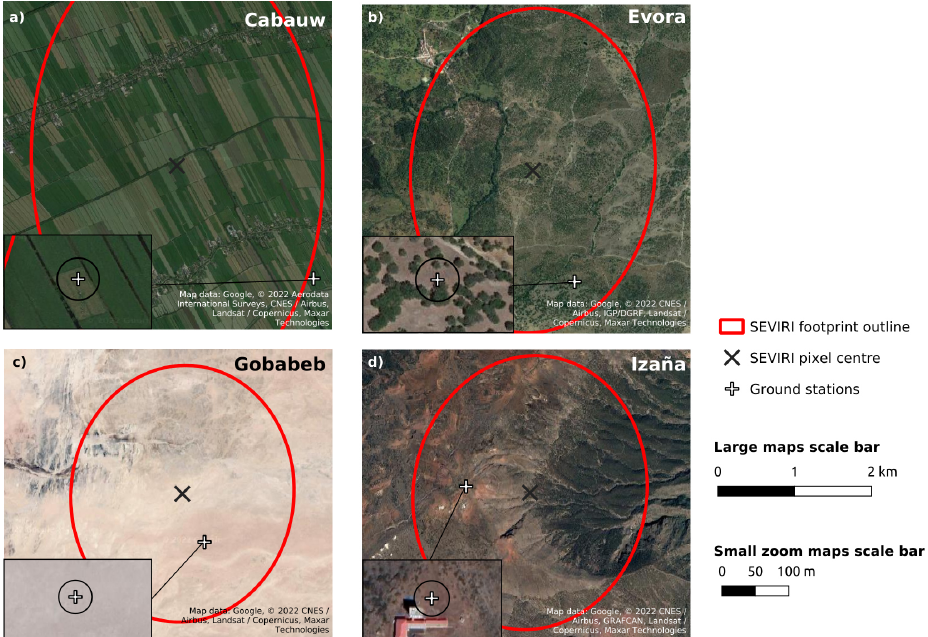
Figure 5. The footprints and surroundings of the in situ stations Cabauw, Evora, Gobabeb and Izaña as well as approximate footprints of the nearest SEVIRI